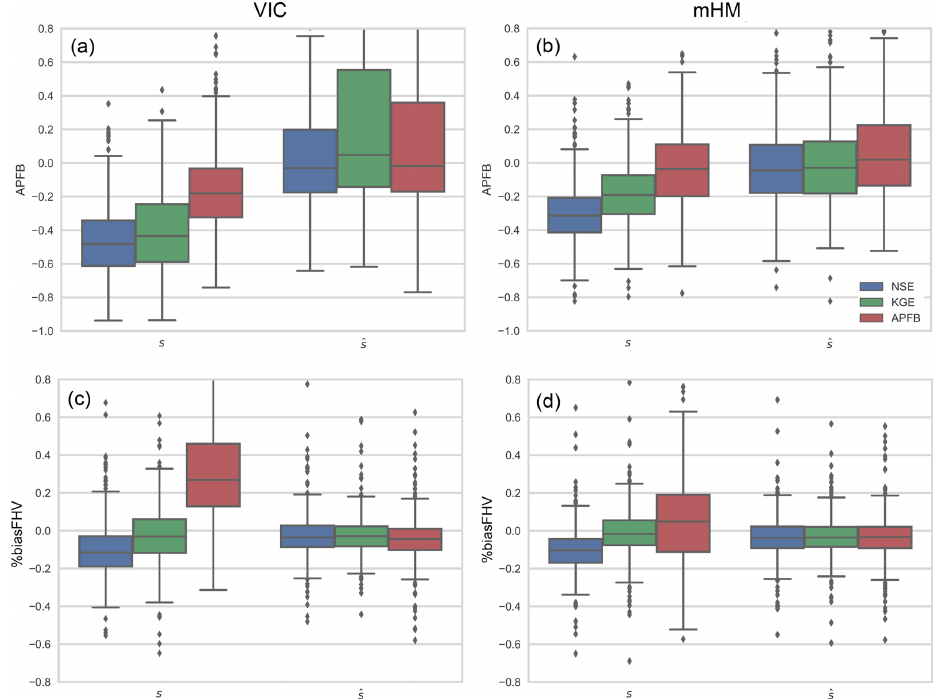
Figure 9. The same as Fig. 8 except for APFB (a, b) and percent bias in FHV (c, d) .